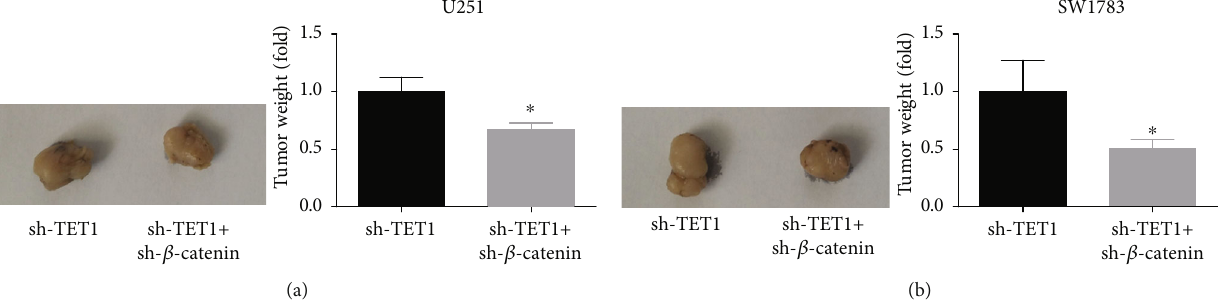
Figure 8: Downregulation of β -catenin inhibited cell growth in vivo. (a, b) U251 and SW1783 cells transfected with TET1 shRAN and cotransfected with TET1 shRNA and β -catenin shRNA were injected into nude mice. After 30d, tumors were excised, and the weight of tumors was calculated. ∗ P < 0 : 05